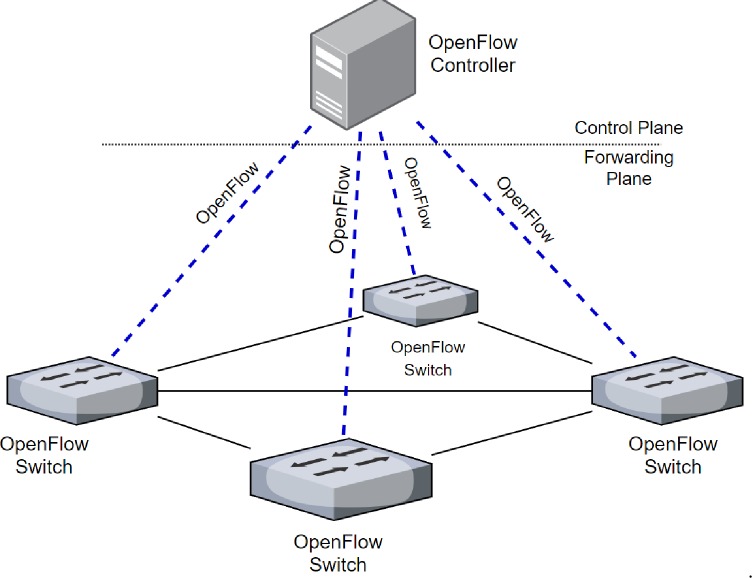
OpenFlow network.